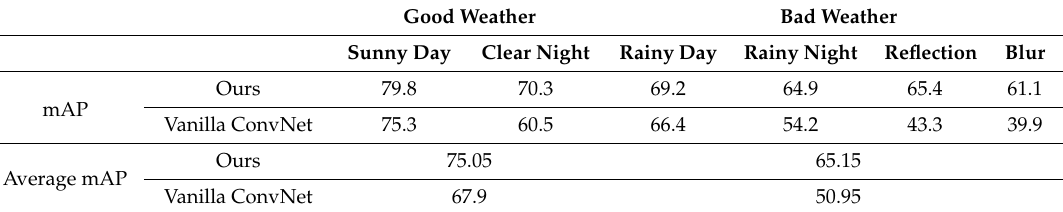
Figure 5. Comparison of all-day detection results reported on the test set. Table 2. Comparison of two multispectral detectors under different weather conditions.